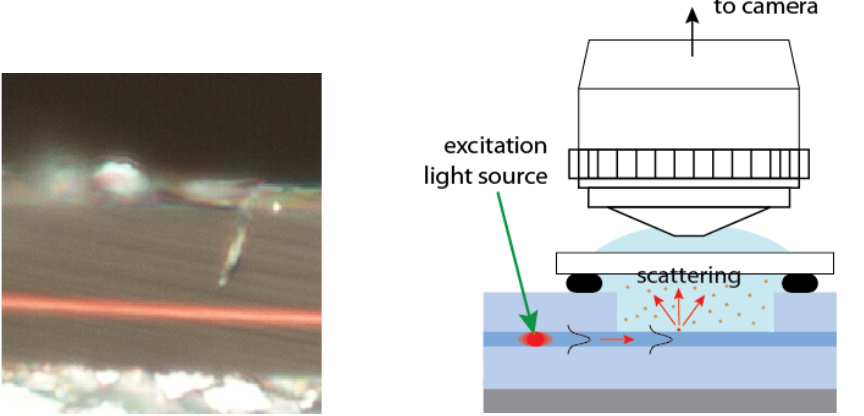
Figure 5. A fluorescent waveguide layer sandwiched between two CYTOP layers acting as an on-chip optically-pumped light source. Red emission from the diced facet of the sample is clearly seen ( left ). The guided fluorescence was used to monitor motion on gold nanoparticles in suspension ( right